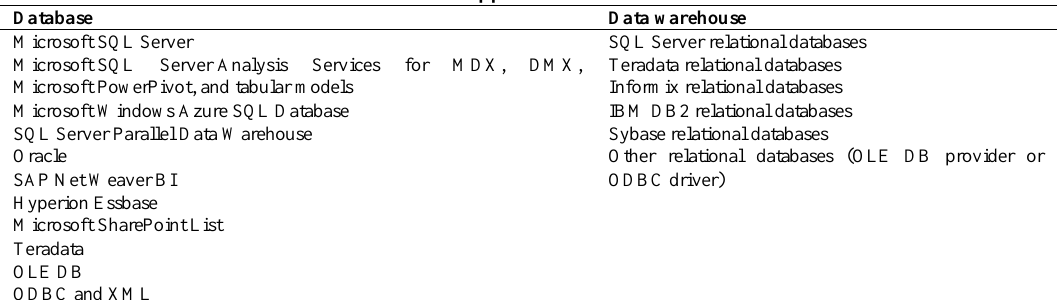
Table 4. Supported data sources.